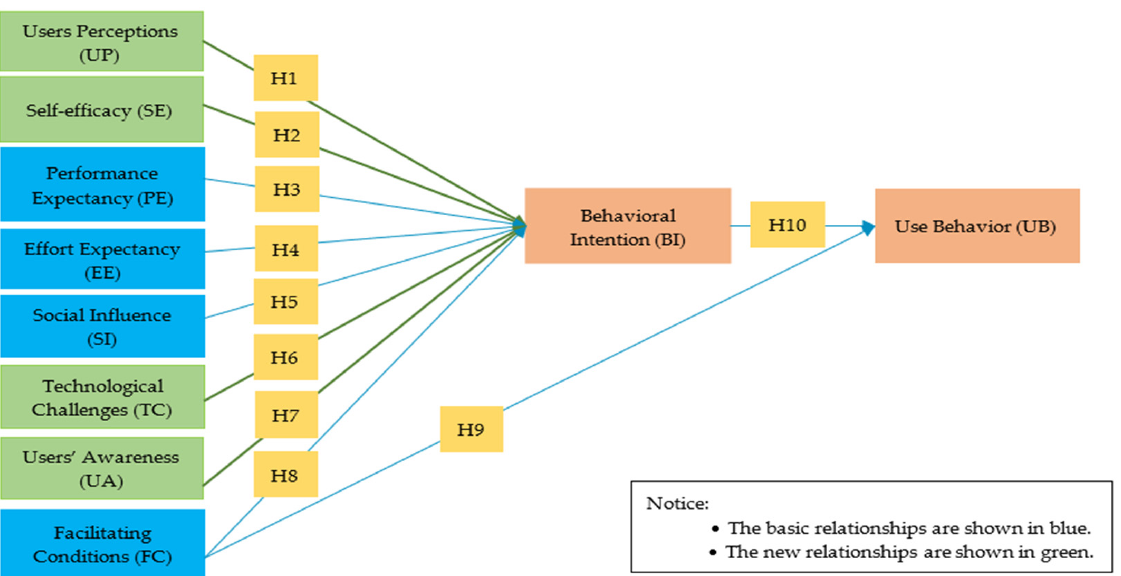
Figure 1. The extending (UTAUT) model.